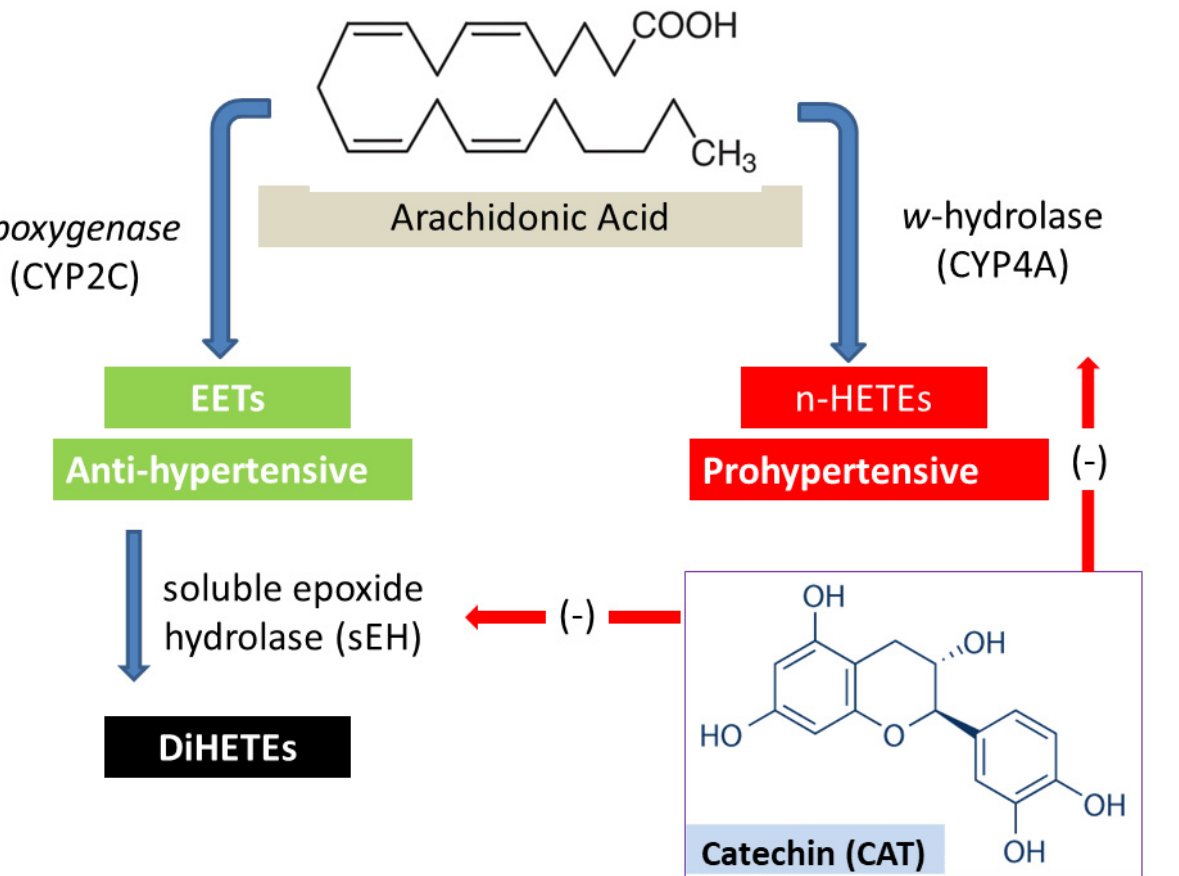
Figure 1. Metabolism of arachidonic acid in the kidney by cytochrome P450 (CYP) enzymes gener- ating vasoconstrictor (n-HETEs) and vasodilator (EETs) metabolites. The hypothesis of the current study is that catechin (CAT) inhibits the w -hydrolase (CYP4A) or soluble epoxide hydrolase (sEH) enzymes, and therefore, reduces blood pressure in SHR.